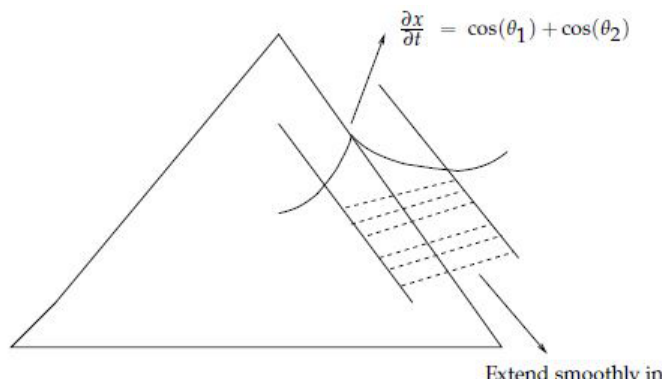
Figure 5. Shortening by straightening.